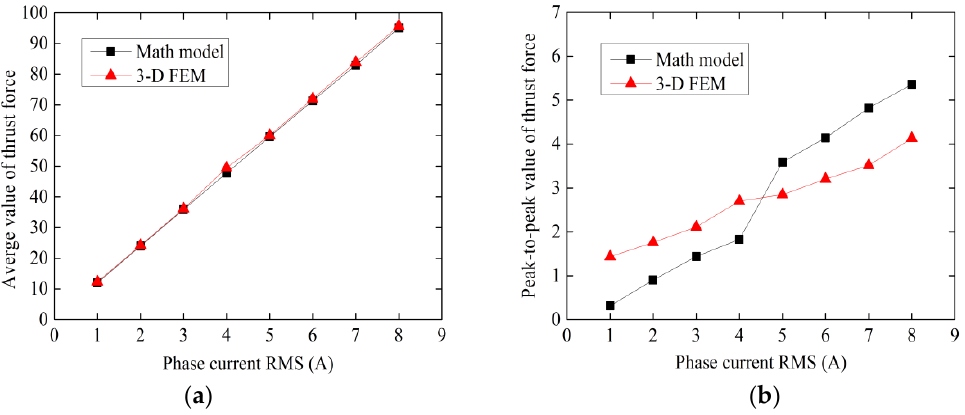
Figure 14. The comparison of results of different methods: ( a ) Average value of thrust force; ( b ) Peak to ‐ peak value of thrust force.